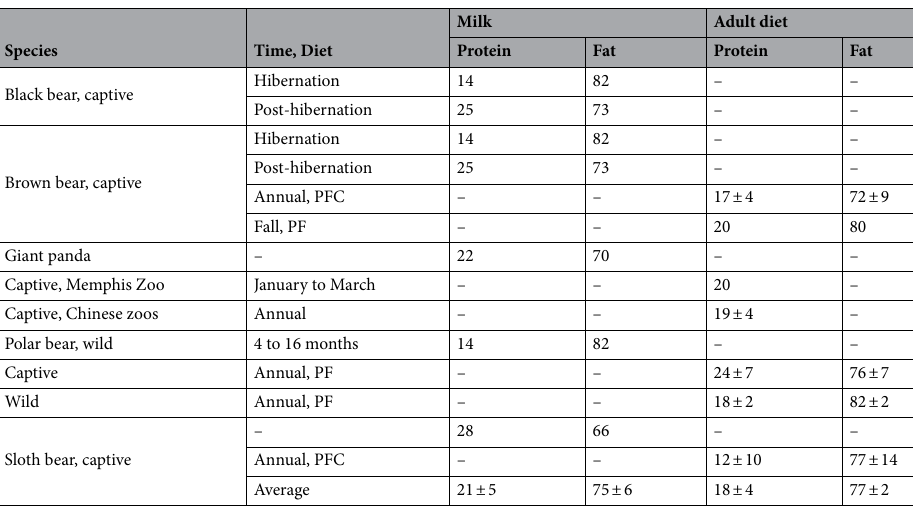
Table 1. The protein and fat metabolizable energy concentrations (%) in ursid milks and in the diets selected by brown bears, polar bears, and sloth bears when given ad libitum access to foods rich in protein, fat, and digestible carbohydrates (PFC) or protein and fat only (PF) 1,3,4,29,32,40,54,55 . The protein metabolizable energy values for the diets of captive giant pandas are for when they were given either ad libitum access to bamboo in the current study at the Memphis Zoo or fed bamboo and other carbohydrate-rich foods in Chinese zoos 32